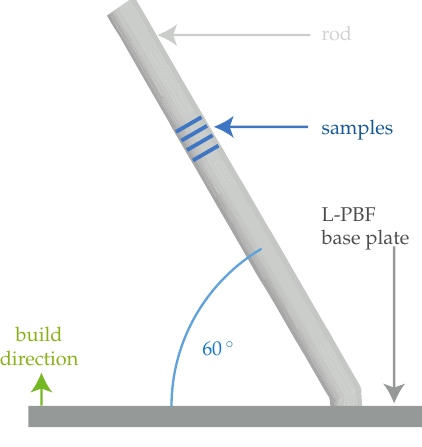
Figure 1. Illustration of the orientation of the samples in the L-PBF